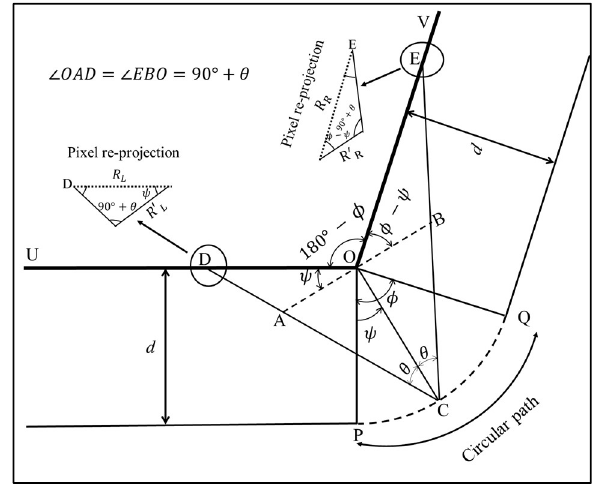
Figure 5. Left and right GSDs of convergent image As shown in the figure above, the left and the right edges of the acquired image will meet at D and E on the left and right planes, respectively. It is evident that GSDs at points D and E may not be equal as the distance OD and OE are not equal. To derive the GSD expressions at short distances, trigonometry and GSD at edge of a normal image are used. Accordingly, line AB is drawn perpendicular to the line OC, which defines the angular position of camera with respect to line OP by angle ψ . For triangles DOA and OBE , all angles are marked. Image pixels at points D and E are highlighted and the GSD at two points are indicated by R , R